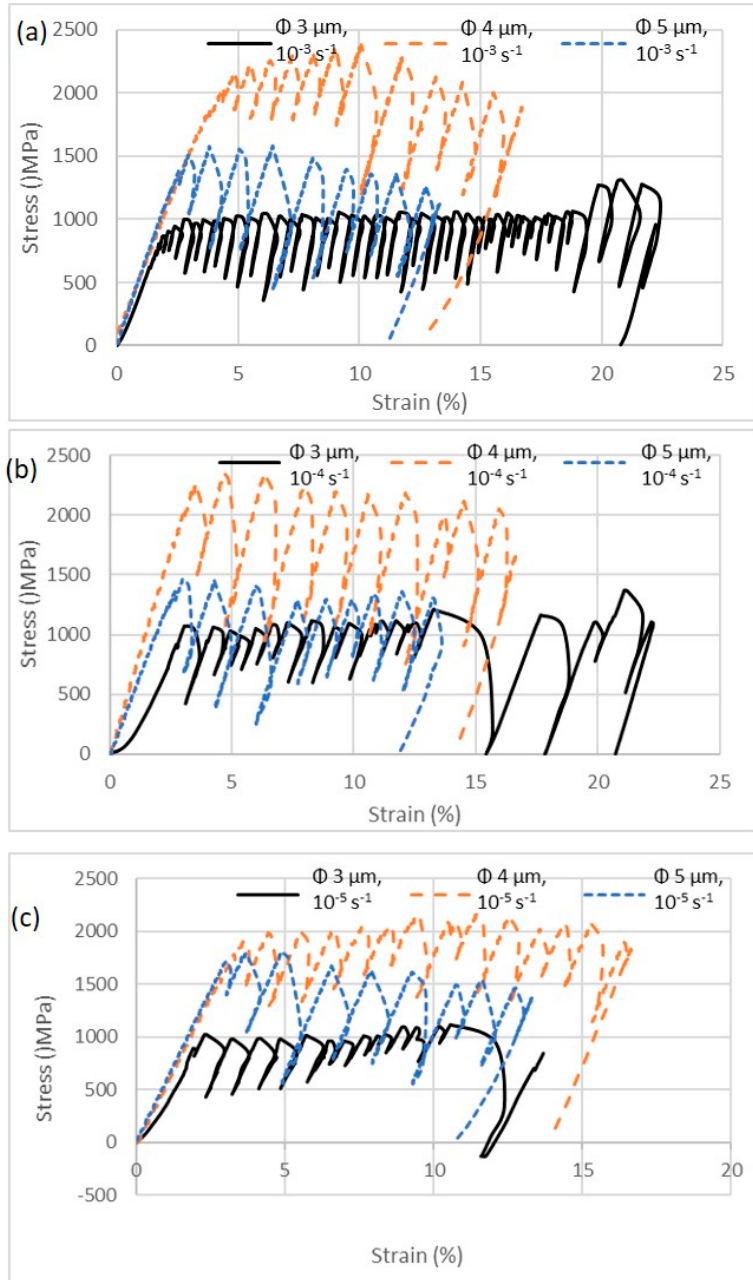
Figure 3. Effect of micro-pillar diameter on stress–strain curves for a given strain rate: ( a ) 10 − 3 , ( b ) 10 − 4 and ( c ) 10 − 5 s − 1 .